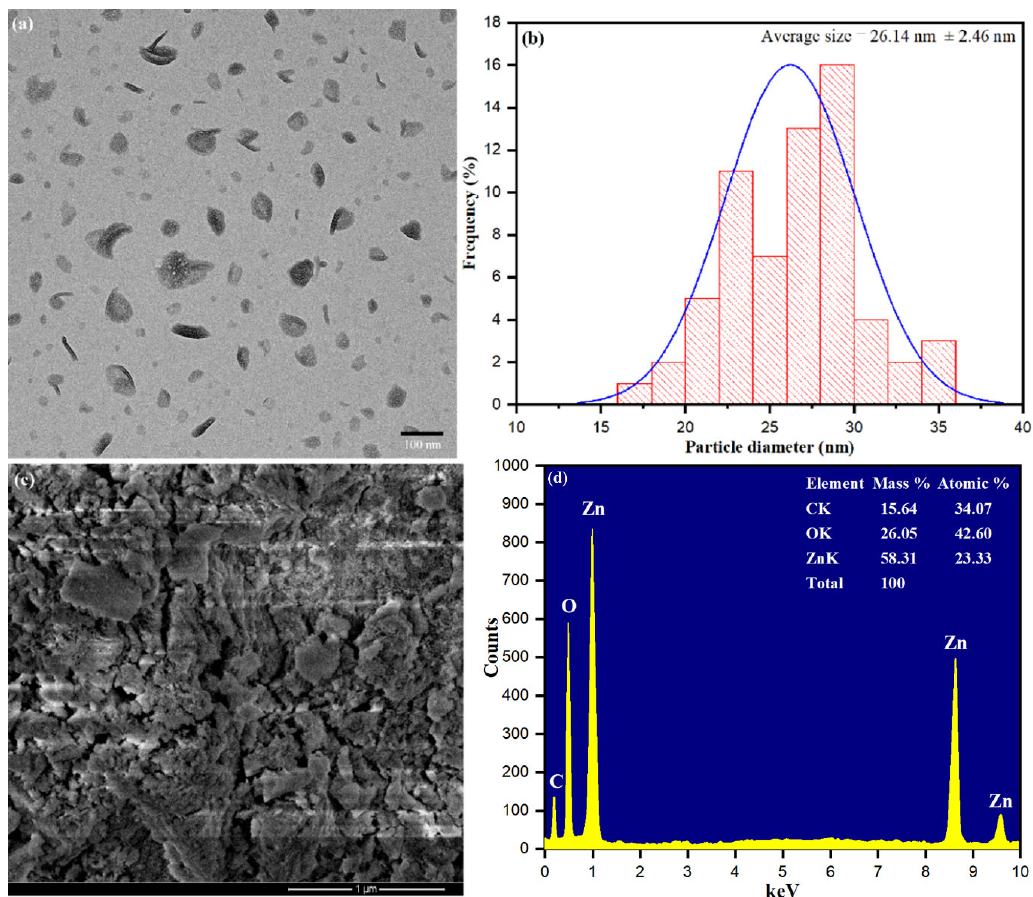
Figure 5. ( a ) Transmission electron microscope (TEM), ( b ) particle size distribution histogram, ( c ) scanning electron microscopy (SEM), ( d ) The EDX spectra of bio ‐ fabricated ZnONPs.